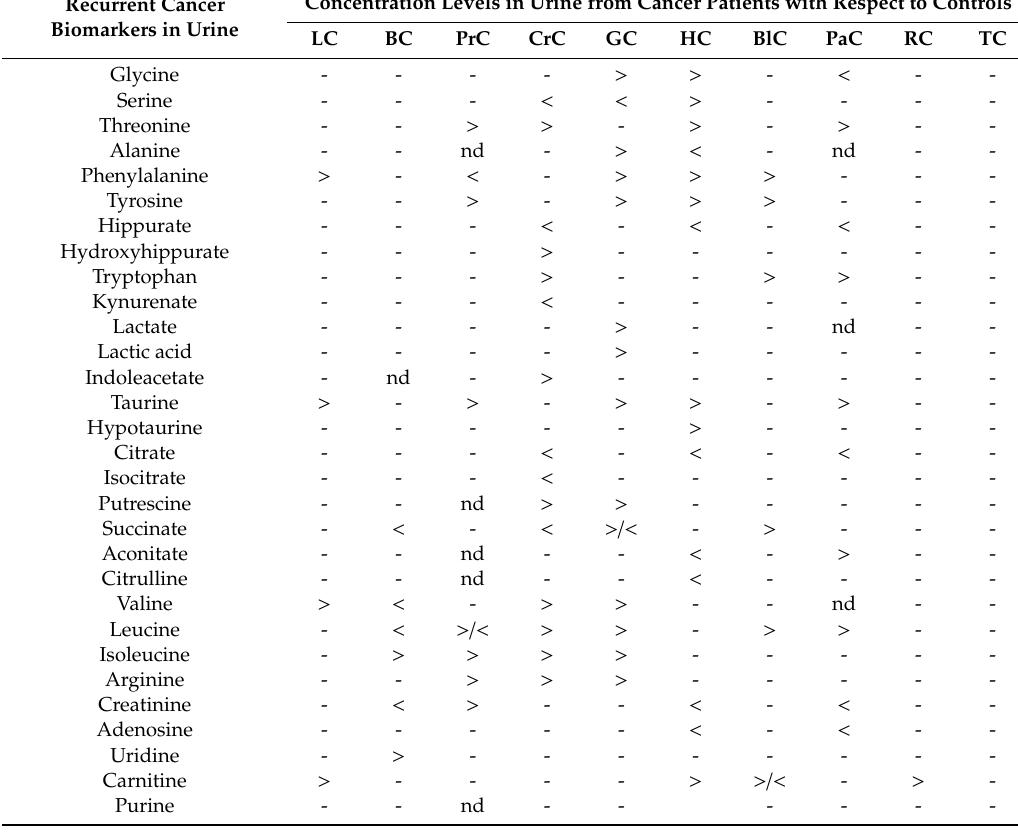
Table 11. Concentration levels of recurrent cancer biomarkers in urine samples from cancer patients with respect to controls ( > higher concentrations; < lower concentrations; nd: no information about concentrations; - no